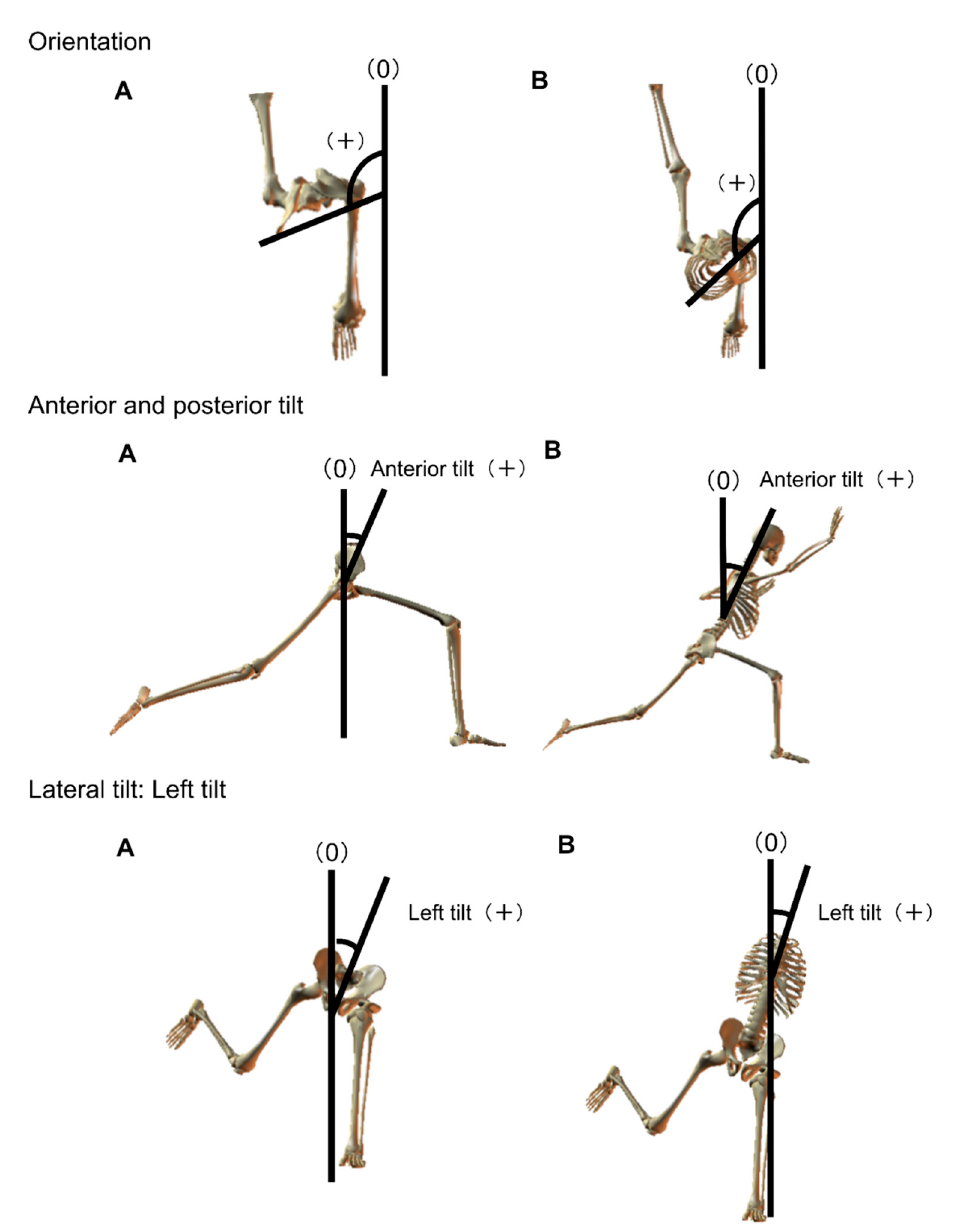
Figure 2. Orientation and tilt of the pelvis and thorax. ( A ): pelvis, ( B ): thorax.